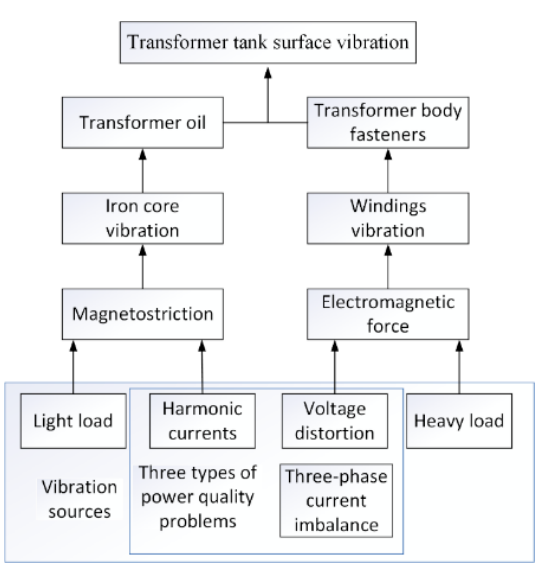
Figure 1. Transformer vibration mechanism model based on power quality.